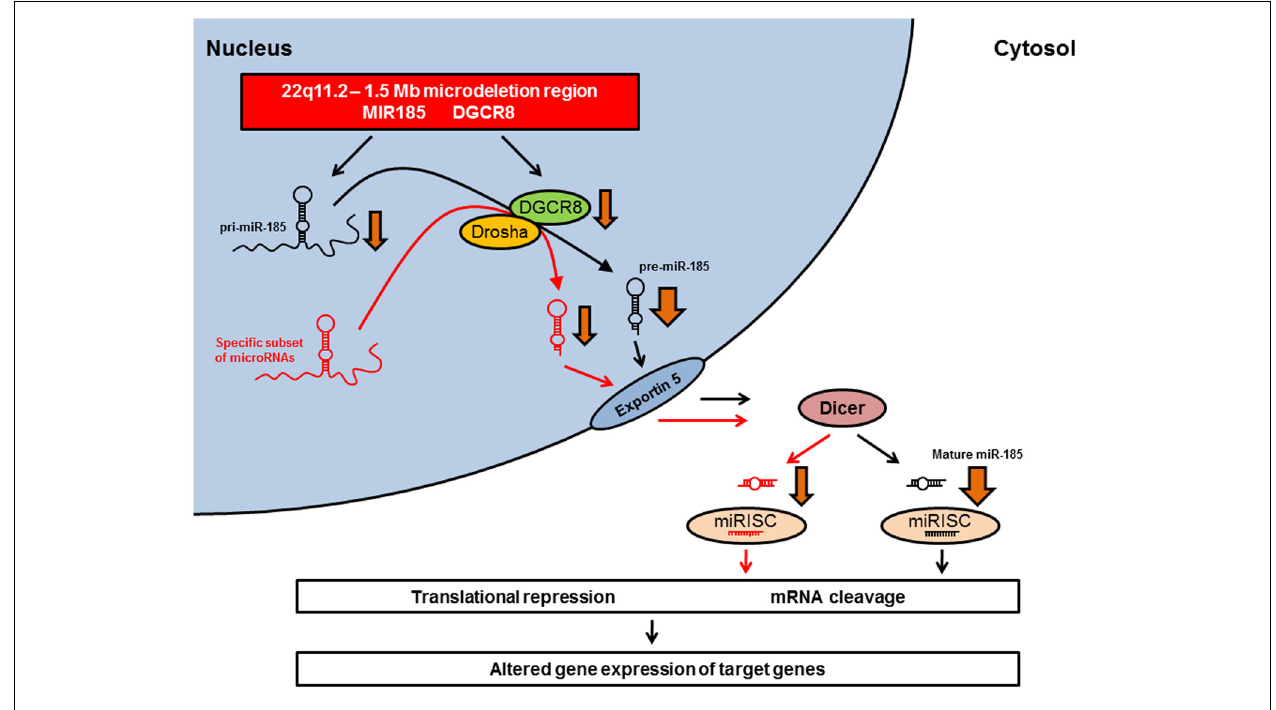
reduction of miR-185 expression (indicated by a broader arrow) may be due to a combined effect of the hemizygosity of the MIR185 gene and the impaired maturation of the pri-miR-185 transcript secondary to reduced Dgcr8 levels (Xu etal., 2013). The resulting alterations in mature microRNA expression levels may lead to altered gene expression of target genes, which might produce some of the neural, cognitive, and behavioral deficits observed in 22q11.2DS. miRISC, microRNA-induced silencing